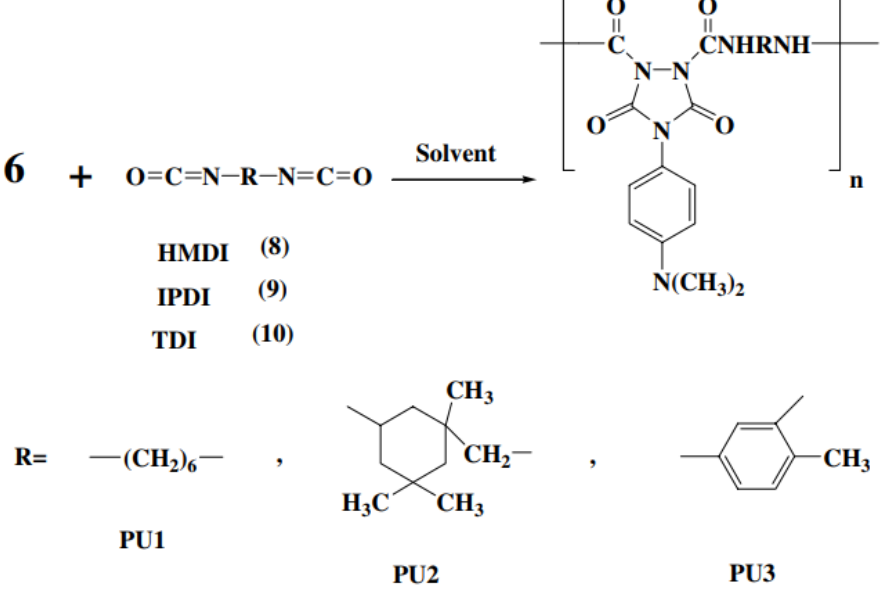
Figure 25. Polycondensation reactions of monomer 6 with diisocyanates. From reference [56].